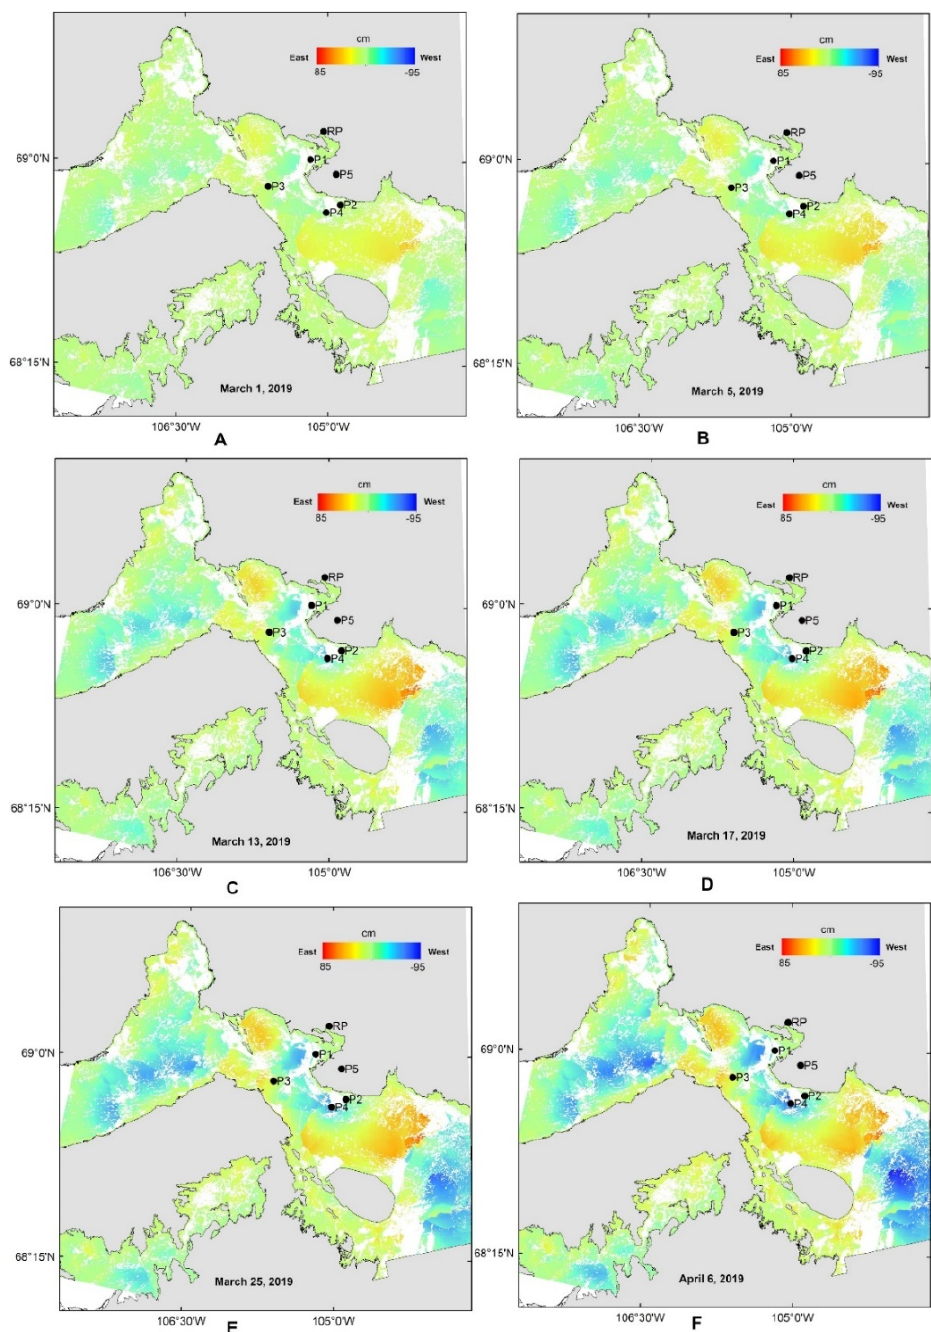
Figure 10. ( A – F ) Horizontal deformation from Sentinel-1A and B modes (+ for west–east move- ment, − for east–west movement). The grey and white color represent land and no measurements,